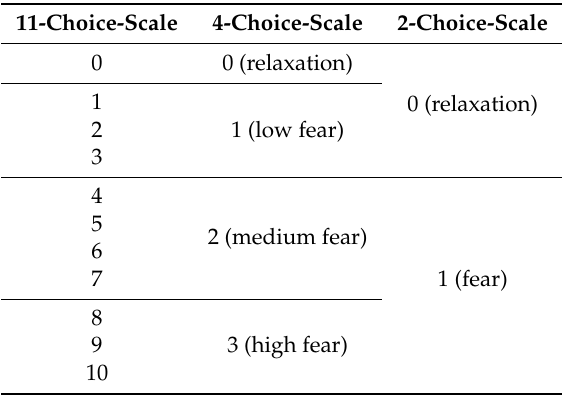
Table 2. Fear level classification